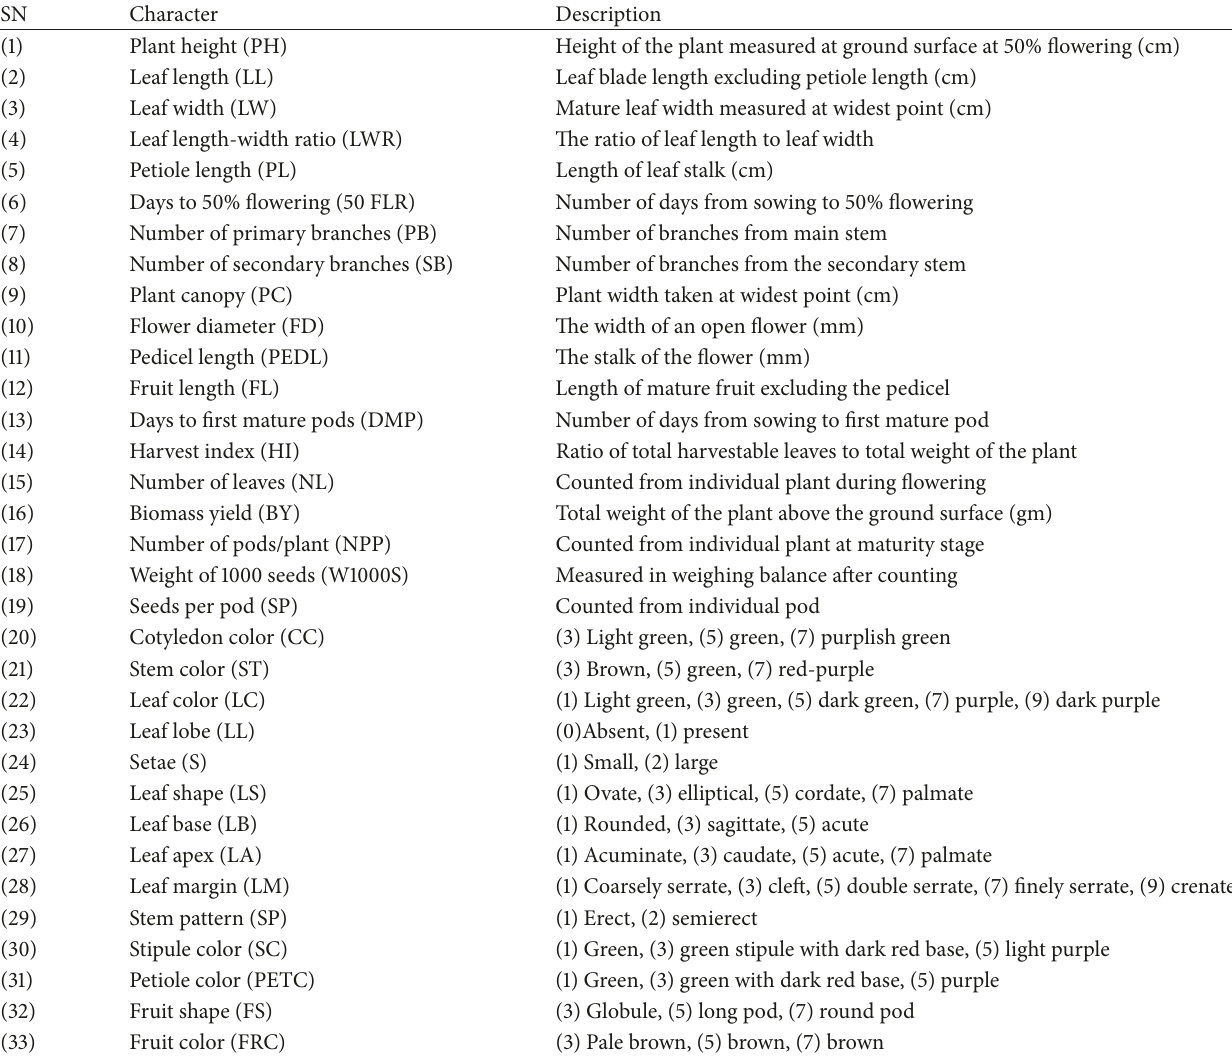
Table 2: Qualitative and quantitative traits used in this